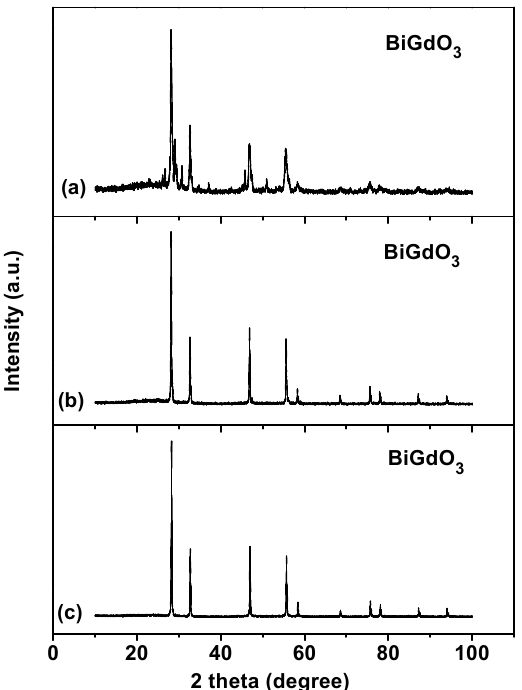
Figure 2. X-ray powder diffraction patterns of BiGdO 3 samples prepared at different temperatures: ( a ) sample prepared at 750 °C for 10 h; ( b ) sample prepared at 1050 °C for 12 h; and ( c ) sample prepared at 750 °C for 10 h, 850 °C for 10 h and then at 1050 °C for 12 h with an intermediate regrinding process.